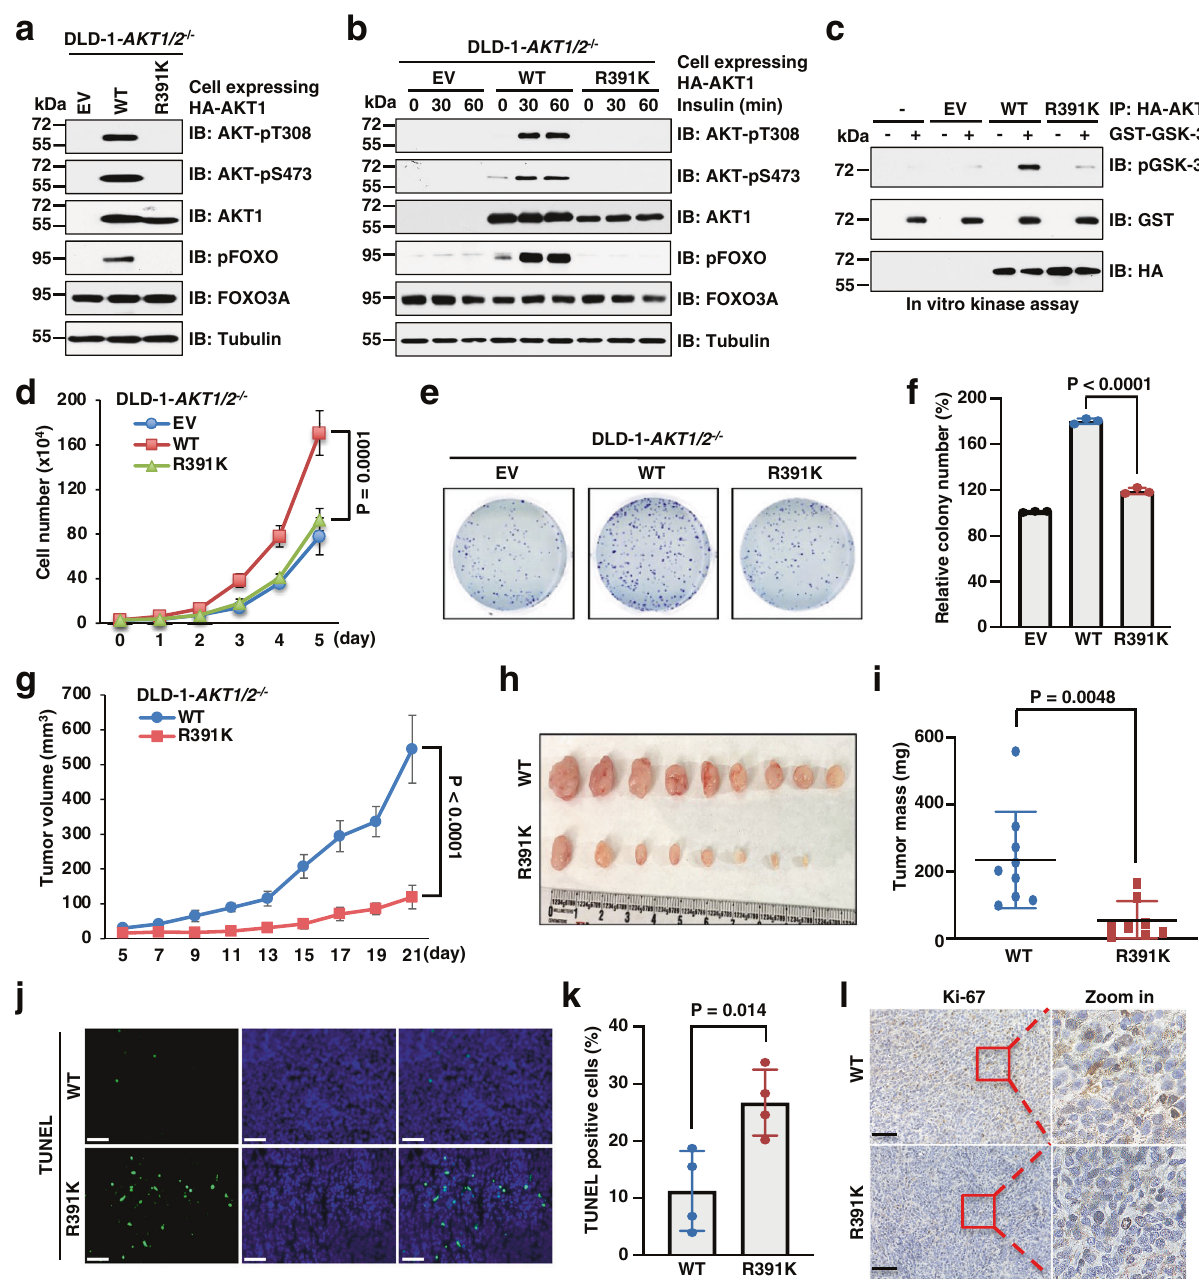
Fig. 6 Absence of R391 methylation attenuates AKT activation and tumor growth. a , b IB analysis of WCLs derived from DLD-1- AKT1/2 − / − cells expressing AKT1-WT or R391K mutant. Where indicated, cells were serum-starved for 16 h and then treated with 100 nM insulin for 0, 30, and 60 min before collection. c In vitro kinase assays using immunopuri fi ed HA-AKT1-WT or R391K as the kinase source and recombinant GST-GSK-3 β puri fi ed from bacteria as the substrate. d DLD-1- AKT1/2 − / − cells expressing AKT1-WT or R391K mutant were subjected to cell proliferation assays. Data are shown as the mean ± SD of n = 3 independent experiments. e Representative images of colony formation assays. f Quanti fi cation of colonies. Data are shown as the mean ± SD of n = 3 independent experiments. g – i DLD-1- AKT1/2 − / − cells expressing AKT1-WT or R391K mutant were subjected to mouse xenograft assays (injection both sides of mice). Tumor growth were monitored ( g ) and dissected tumors were weighed ( h , i ). Data are shown as the mean ± SEM g or mean ± SD ( i ) of n = 5 mice (WT) or 4 mice (R391K). j Representative images of TUNEL assays in xenograft tumors. Scale bar, 50 μ m. k Quanti fi cation of TUNEL-positive cells in xenograft tumors. Data are shown as the mean ± SD of n = 4 tumors. l Representative images of IHC staining of Ki-67 in n = 4 xenograft tumors. Scale bar, 100 μ m. Statistical signi fi cance was determined by two-tailed Student ’ s t -test in f , i , k and by two-way ANOVA in d , g . Similar results were obtained in n ≥ 2 independent experiments in a – c . Uncropped immunoblots and statistical source data are provided in Source Data fi